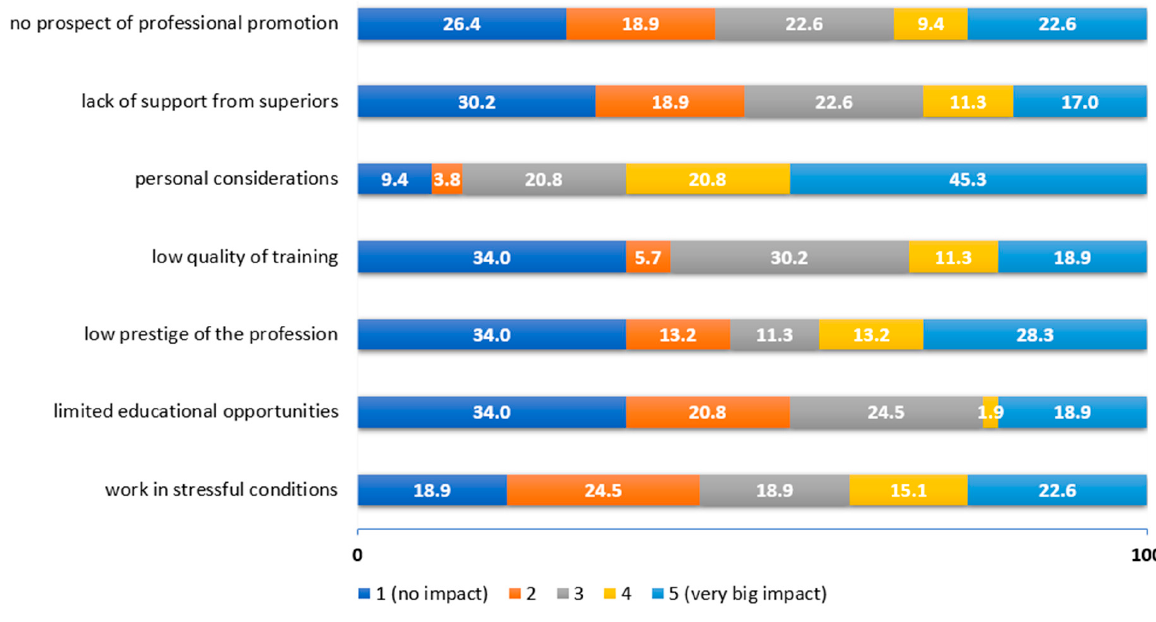
Figure 2. Assessment of the influence of pull factors according to students of physiotherapy.